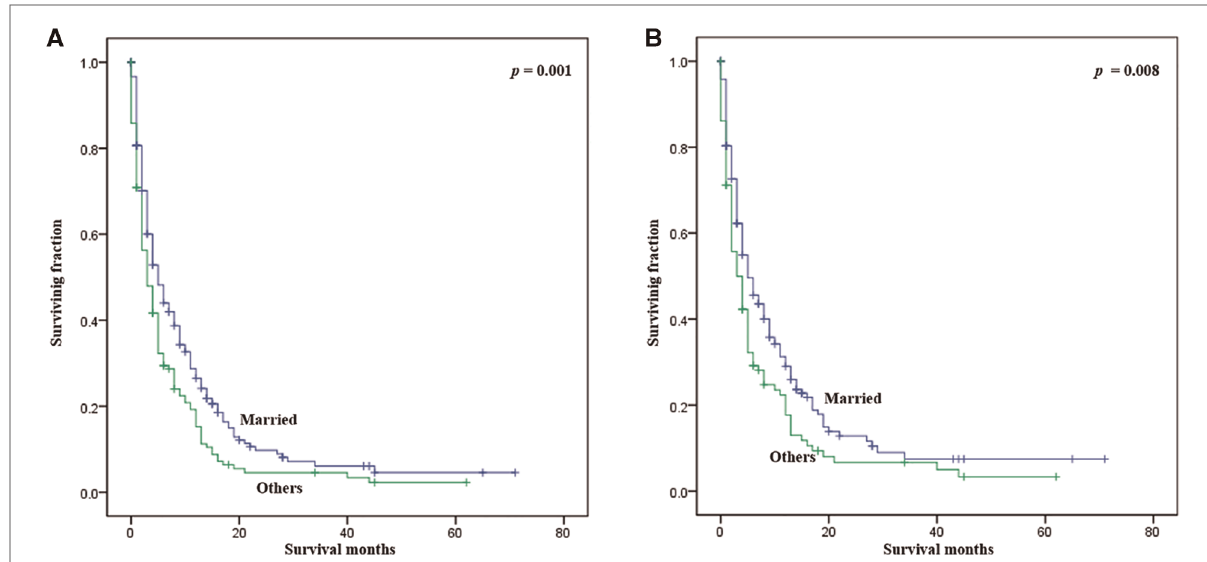
FIGURE 4 Kaplan-Meier method estimated OS and CSS in UTUC patients with bone metastasis strati fi ed by marital status. ( A ) OS strati fi ed by marital status; ( B ) CSS strati fi ed by marital status. (UTUC, upper-tract urothelial carcinoma; OS, overall survival; CSS: cancer-speci fi c survival).